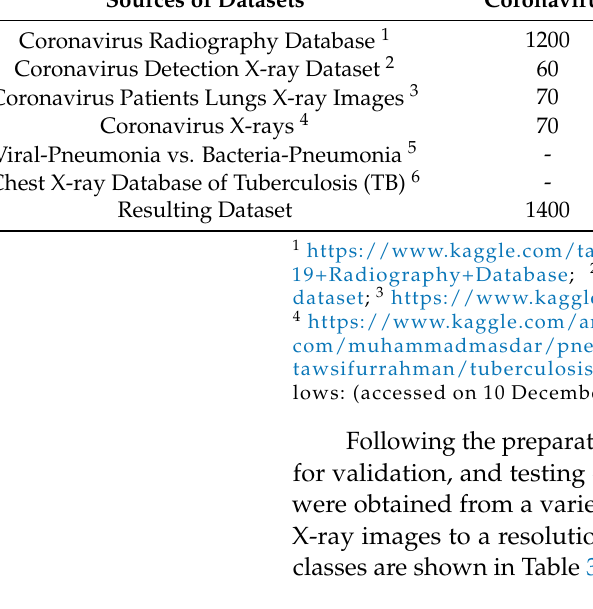
Table 3. The dataset partitions of used dataset